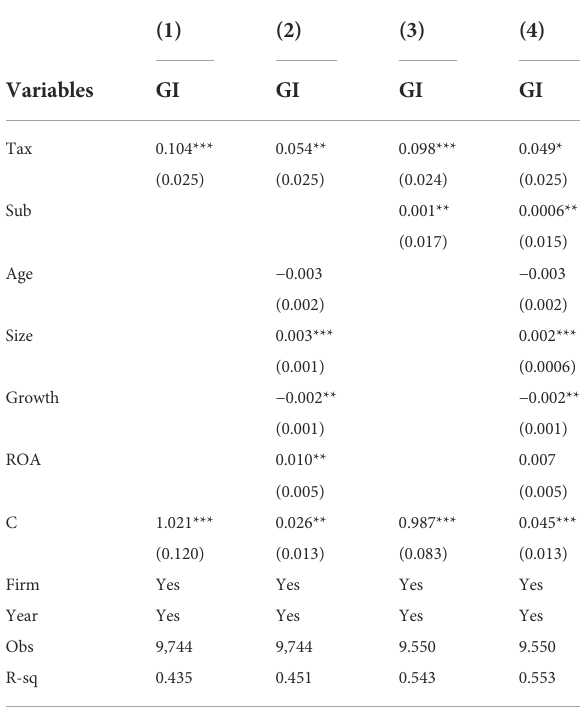
TABLE 3 Baseline regression result. TABLE 4 Mediating and moderating effects